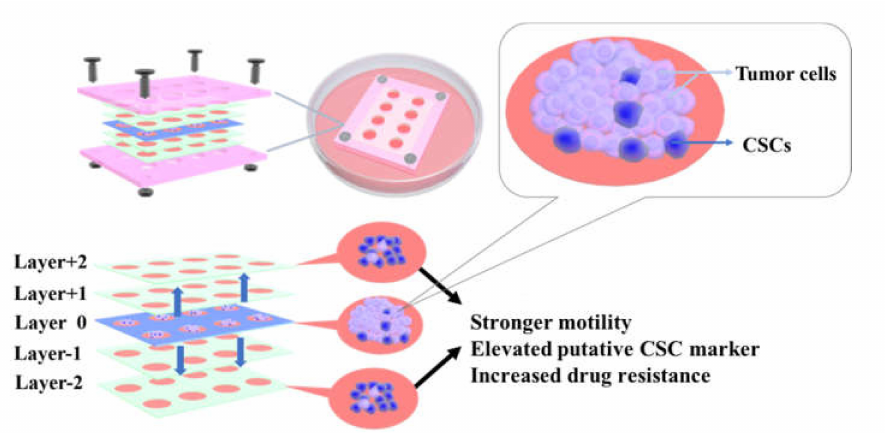
Scheme 1. Schematic drawing of the multi-layer CiGiP cell invasion platform mimicking the in vivo tumor metastasis process. Separation and isolation of subtype of tumors according to their motility can be achieved by de-stacking of the multi-layer invasion platform. The elevated expression of the putative cancer stem cell (CSC) biomarker suggests the relationship between stemness and